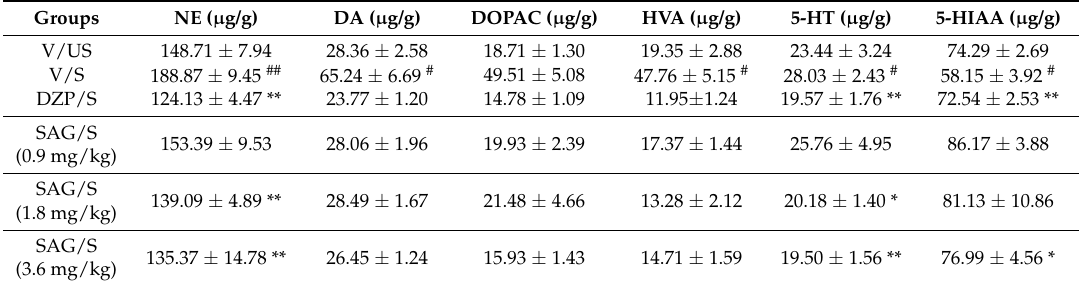
Table 2. Effect of SAG on the monoamine neurotransmitters and their metabolites in the hippocampus of